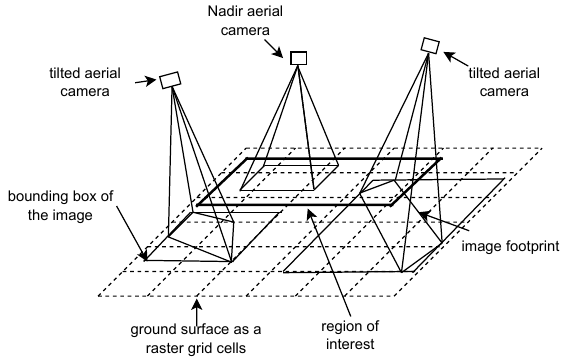
Figure 1. ground footprint of aerial images